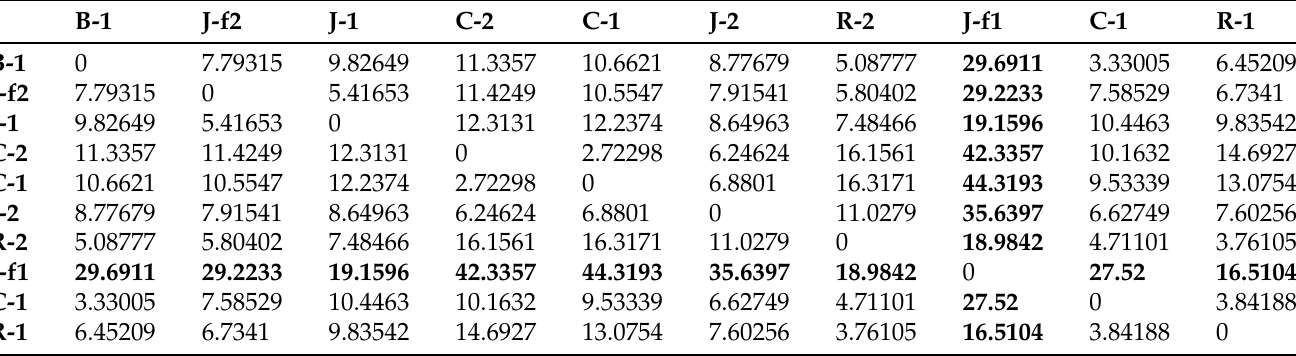
Table 4. Pairwise DTW “speaker-speaker” for one